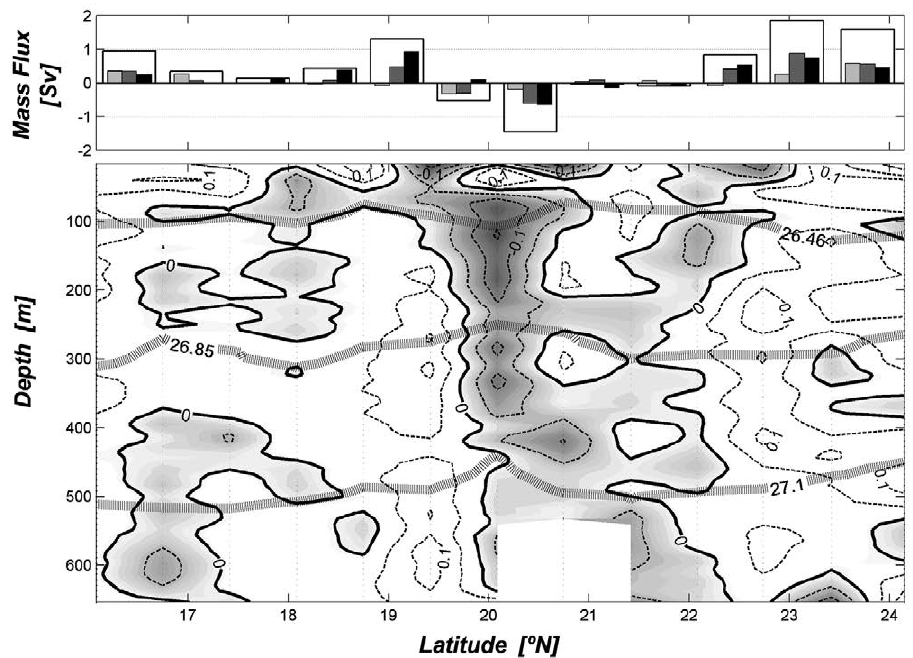
F ig . 8. – Bottom panel: Distribution of zonal velocity on the 2000-m isobath along-slope section (Fig. 1) (in [m s –1 ]; contours are drawn every 0.05 m s –1 ; positive values denote eastward flow, westward velocities are shaded in grey). The grey thick lines show the three selected isopyc- nals (26.46, 26.85 and 27.1). Top panel: Corresponding zonal transports per water stratum as calculated between each pair of stations located along the 2000-m isobath section; SW (light gray), uCW (gray), lCW (dark gray) and the total (box); positive values denote eastward